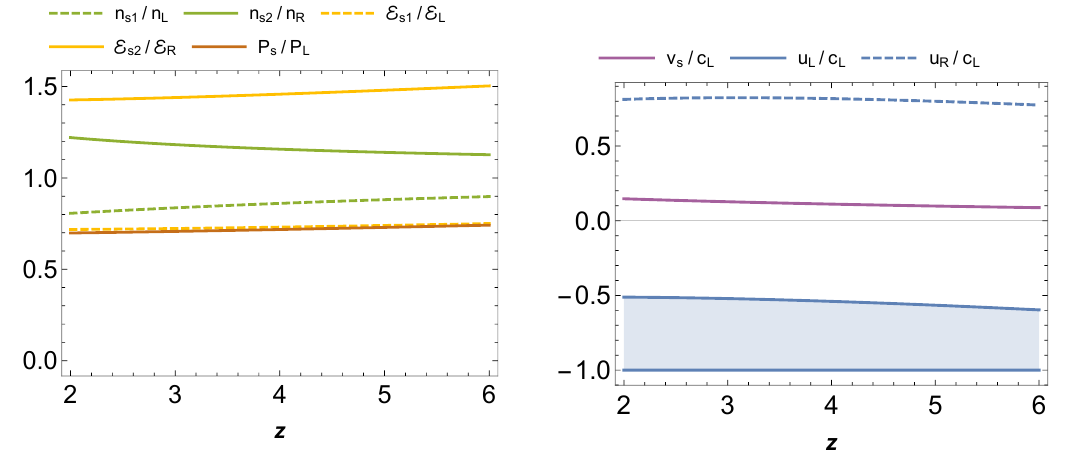
Figure 7. NESS variables as a function of z for d = 3 and (cid:12)xed P L =P R = n L =n R =